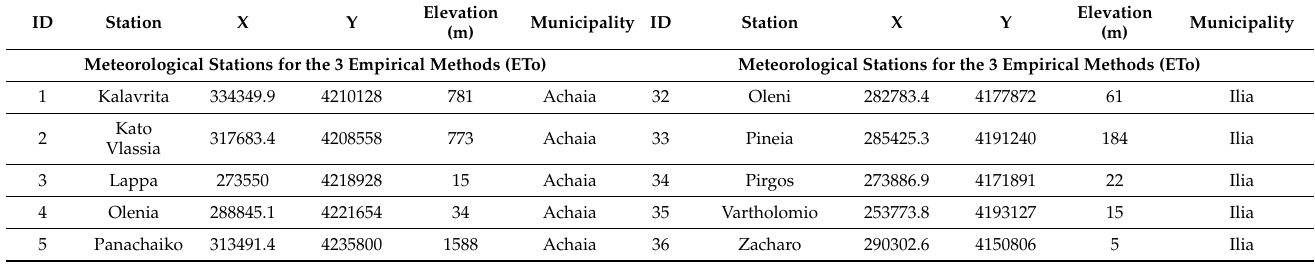
Table A1. Meteorological stations (62) used (source: https://meteosearch.meteo.gr (accessed on 15 April